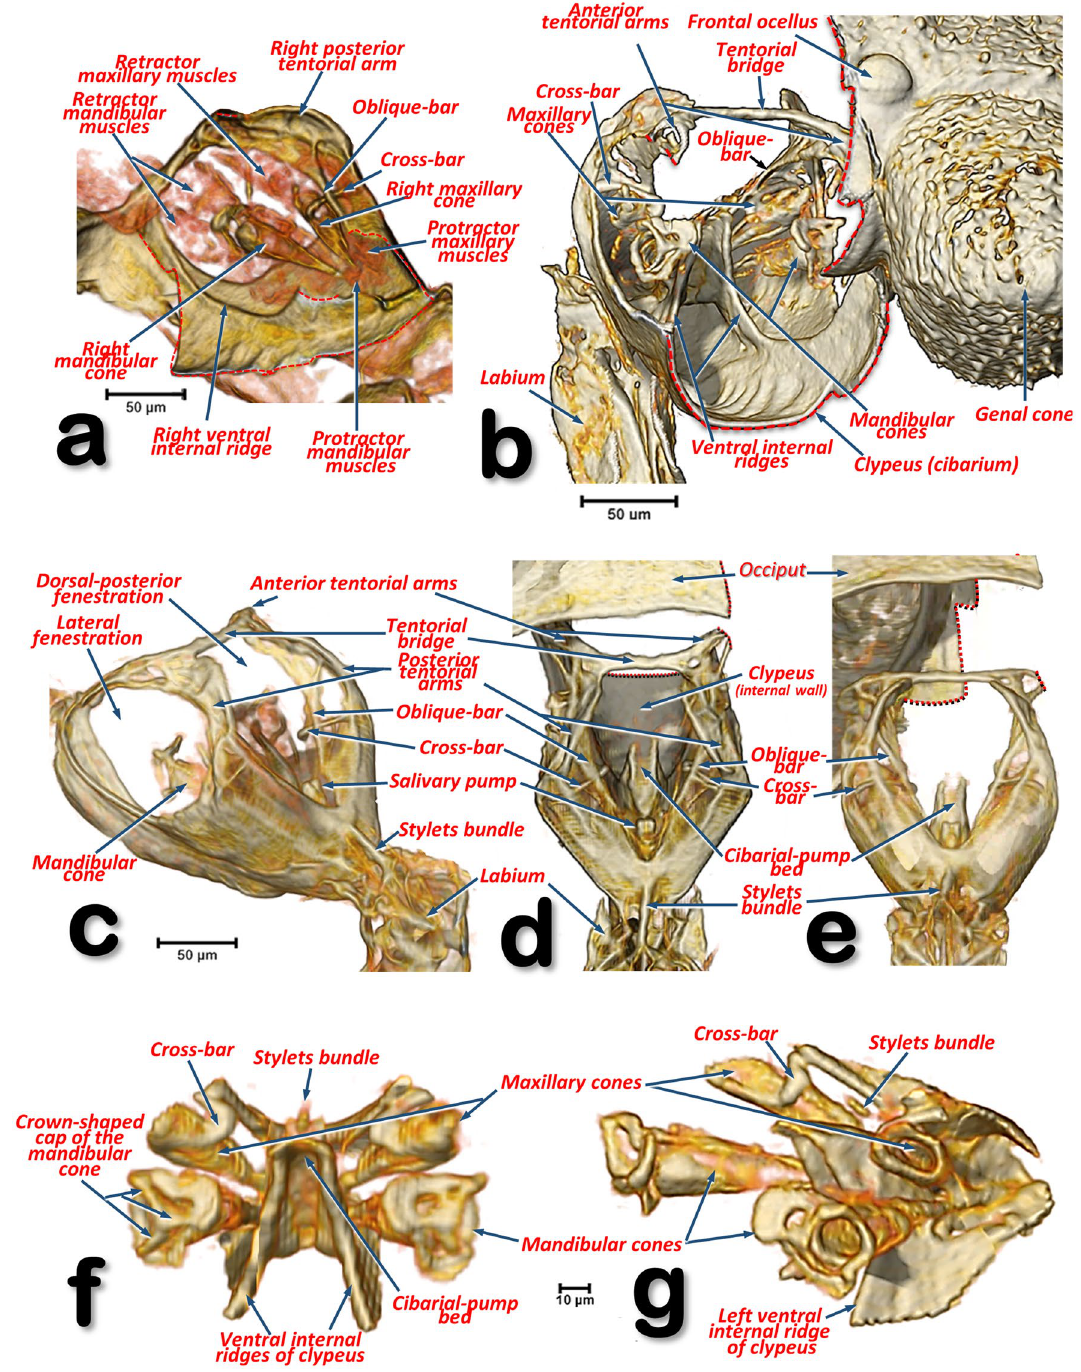
Figure 17. Volume-rendered detailed images of the feeding apparatus and tentorium of a male Diaphorina citri in different perspective views. Left-lateral ( a , g ), right-frontal ( b ), left-posterior ( c ), dorsal ( d ), posterior ( e ), frontal ( f ). Volume close-up images of the cibarium: internal right-side view, with the maxillary and mandibular cones rendered ( a ), and only the ‘harder’ structures ( b – g ). Details of the mandibular and maxillary cones ( f , g ). To be able to see inside the cibarium, different virtual cuts were made using software (cuts are indicated with dotted red the crumenal pouch; when stored, this forms a characteristic crumenal loop (Figs. 11a, 12b, 15 and Supplemen- tary Videos S5, S7). This loop passes through the nerve cord behind the subesophageal ganglion (Figs. 11a, 12b and Supplementary Videos S5–S7).